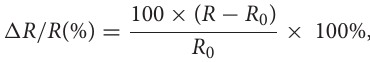
10 mg of GO was sonicated in 50 ml DIW for 30 min. Then, 0.5